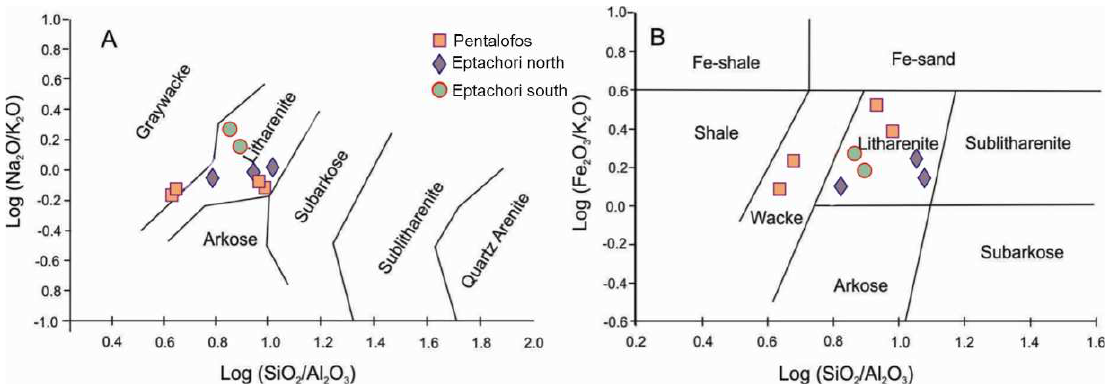
Figure 5. Binary classification plots of ( A ) log (SiO 2 /Al 2 O 3 ) vs. log (Na 2 O/K 2 O) of Pettijohn et al. [35], and ( B ) log (SiO 2 /Al 2 O 3 ) vs. log (Fe 2 O 3 /K 2 O) diagram of Herron [36]. Table 4. Whole-rock major (wt.%) and trace element (ppm) compositions of the studied sandstone samples.